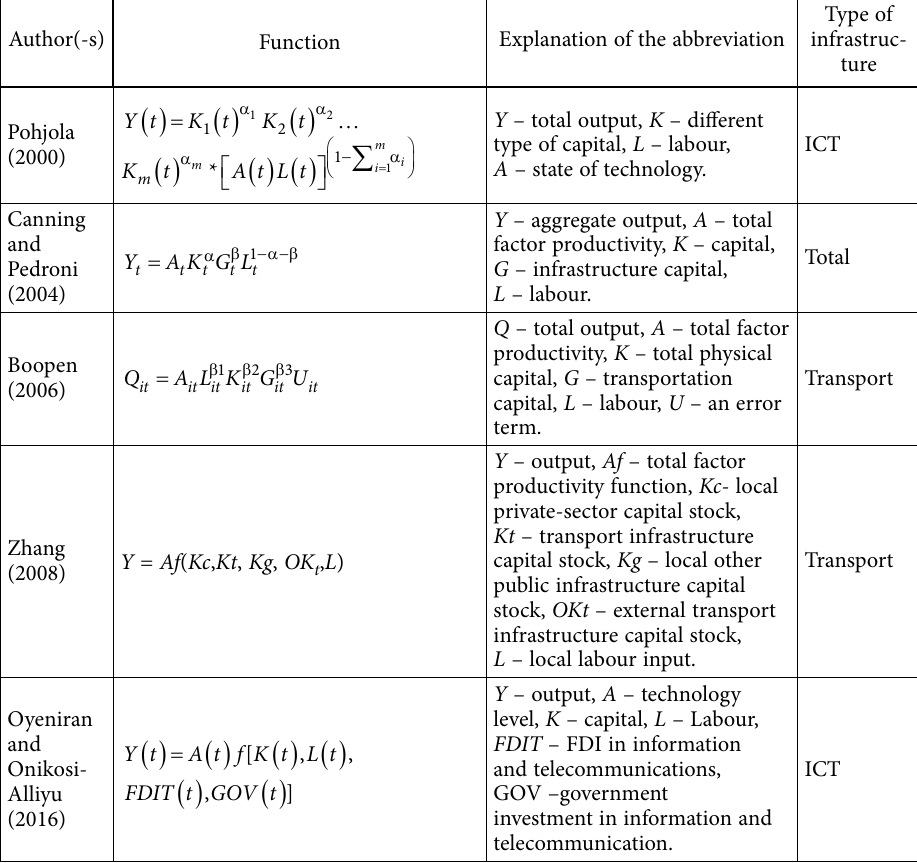
Table 1. Functions used in previous studies to justify infrastructure impact on economic growth (source: composed by the authors based on a literature